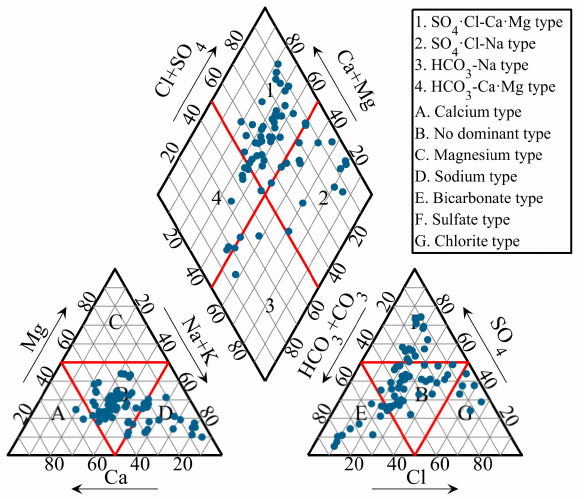
Figure 4. Piper diagram of groundwater chemical composition in the Shizuishan area.